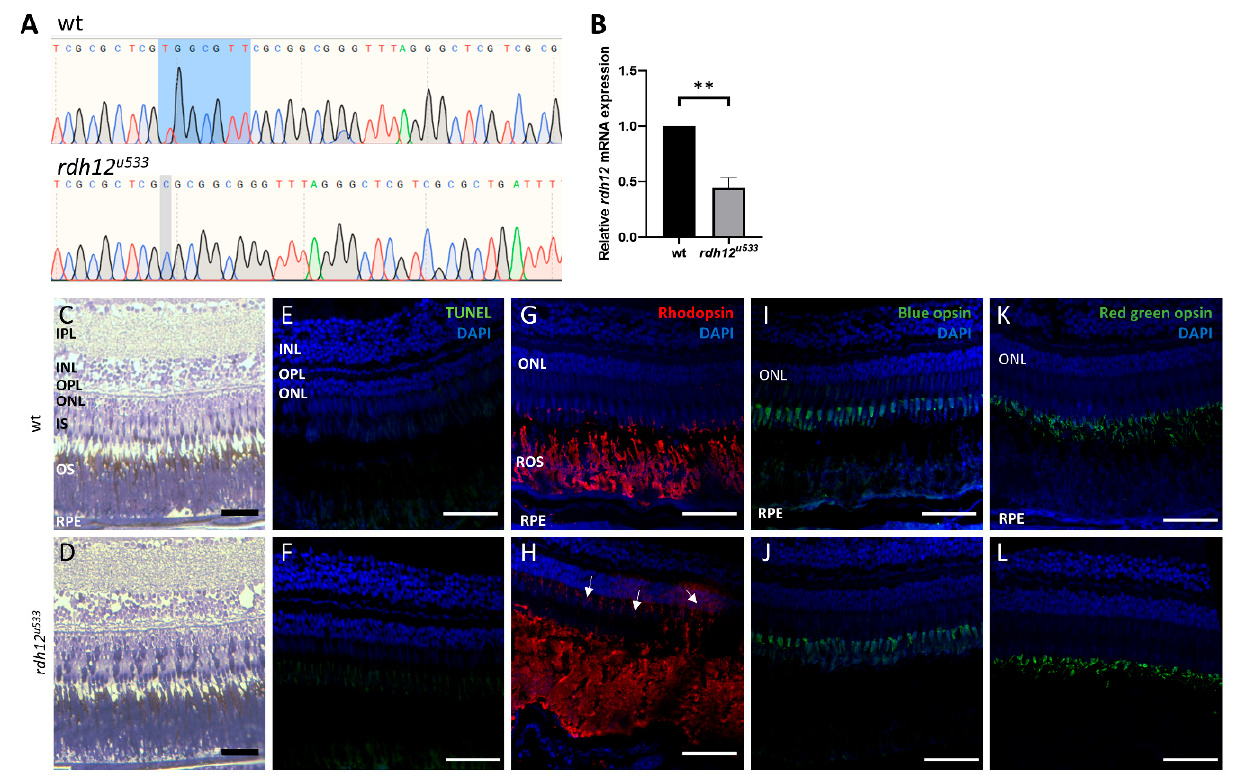
Figure 4. Generation and characterisation of rdh12 u533 mutant zebrafish. ( A ) Sanger sequencing traces showed a 7 bp deletion (c.17_23del) in the rdh12 u533 mutant fish. The deleted bases are highlighted in blue on the wildtype trace. ( B ) RT-qPCR showed a significant reduction of rdh12 mRNA expression in the rdh12 u533 fish at 5 dpf (** p ≤ 0.001 analysed by paired t -test). ( C , D ) Retinal sections from 12 mpf fish were stained with toluidine blue to assess retinal structure. ( E , F ) TUNEL assay revealed no cell death Immunohistochemistry staining was used to detect rhodopsin (red) ( G , H ), blue opsin (green) ( I , J ), and red/green opsin (green) ( K , L ). Sections were counterstained with DAPI (blue). Rhodopsin mislocalisation was observed in rdh12 u533 fish. Scale bar = 50 µM. IPL, inner plexiform layer; INL, inner nuclear layer; OPL, outer plexiform layer; ONL, outer nuclear layer; IS, inner segment; OS, outer segment; RPE, retinal pigment epithelium.